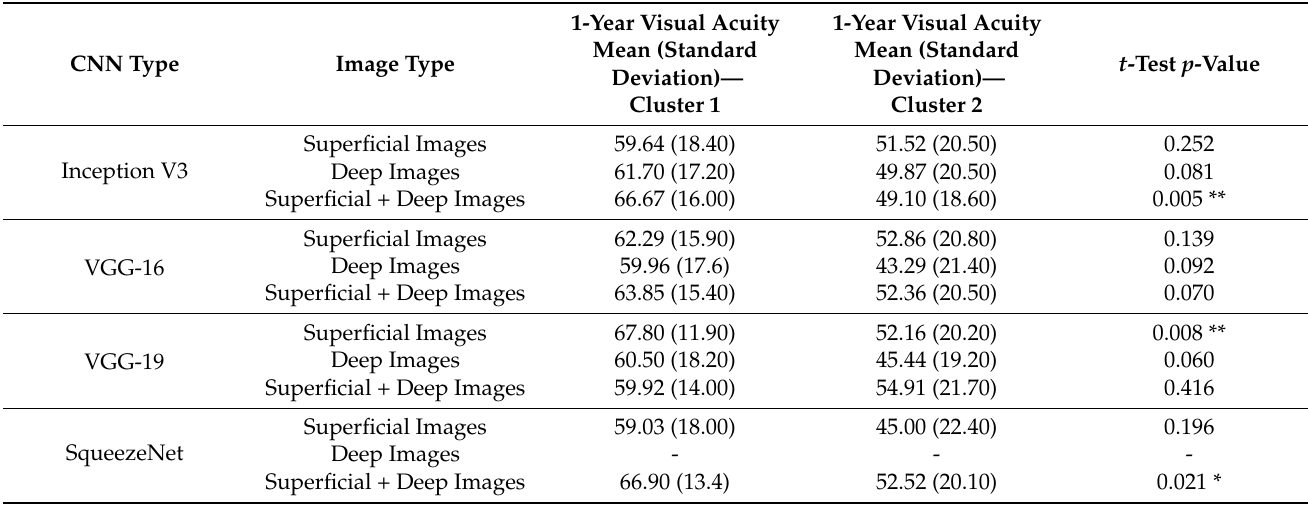
Table 2. Distribution of 1-year visual acuity score in the two image clusters for the different CNN